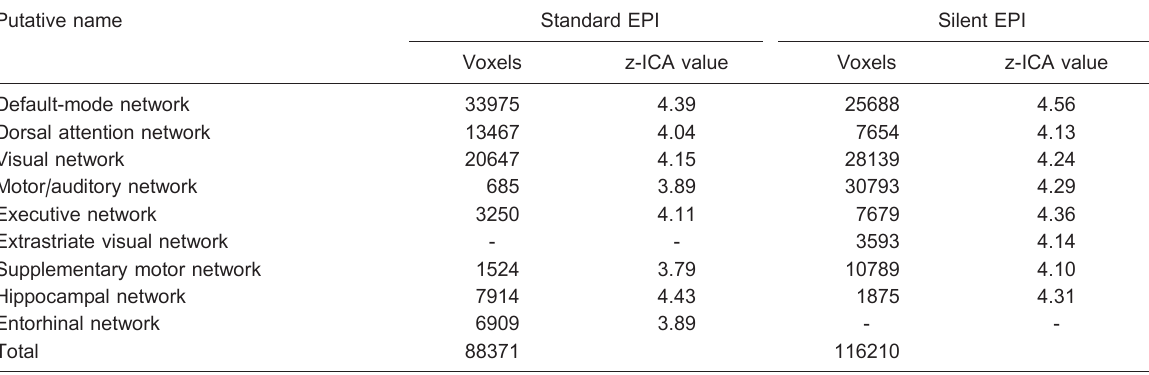
Table 1. Networks detected under both noise conditions, voxel number and mean RFX group z-ICA transformed values inside each network in the presence of each acoustic noise level. Putative name